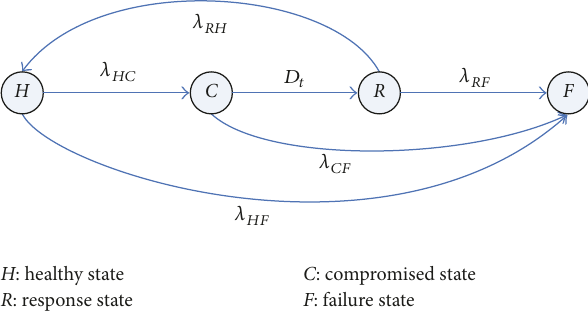
Figure 1: The value of 𝐷 𝑡 for several planning